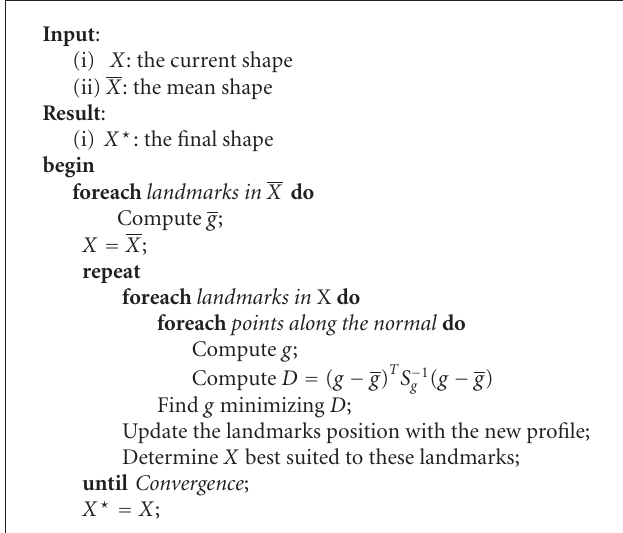
Algorithm 3: ASM segmentation